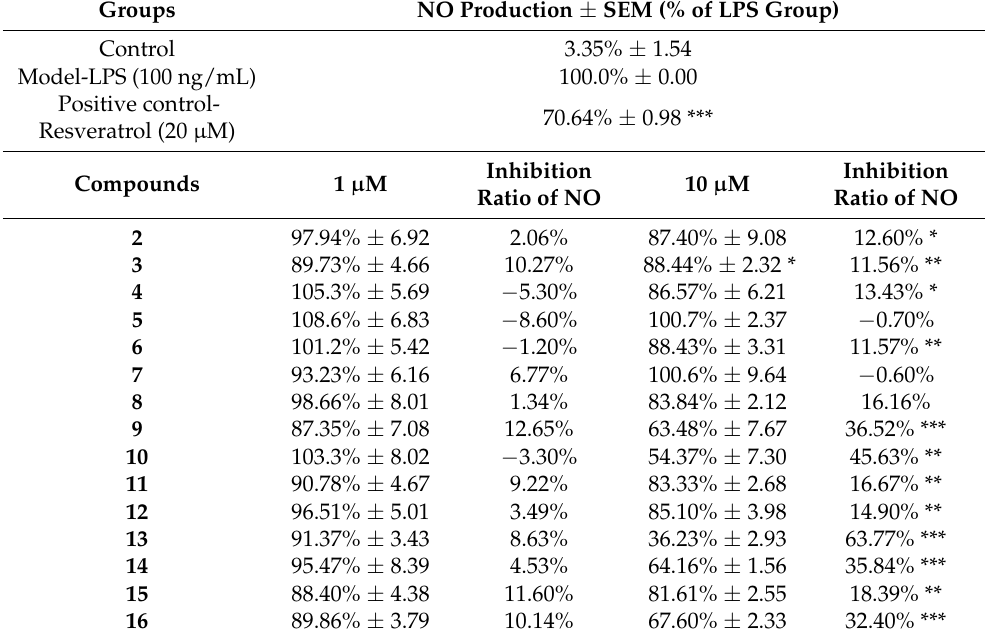
Table 2. The ameliorating effects of compounds on LPS-induced BV2 cell inflammation.